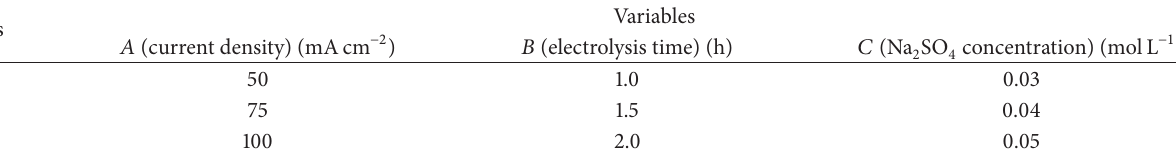
Figure 4: Effect of pH on quinoline degradation (a) and TOC removal (b). Table 1: Factors and levels of orthogonal test.